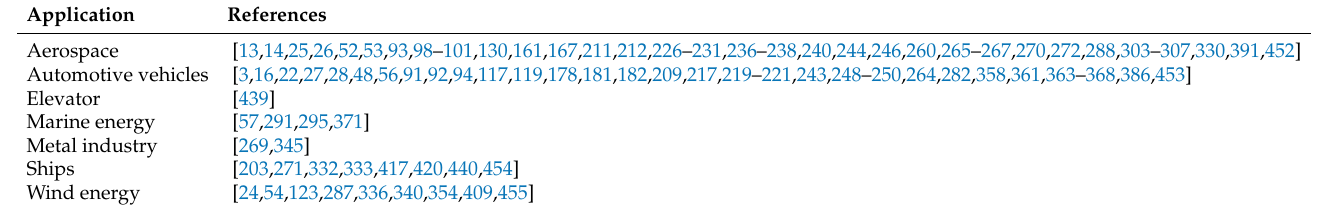
Table 2. Classification of references about fault tolerance in multiphase drives according to specific applications.